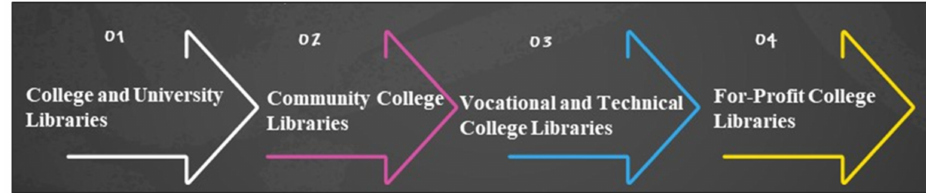
Figure 2. The diagram shows the types of academic